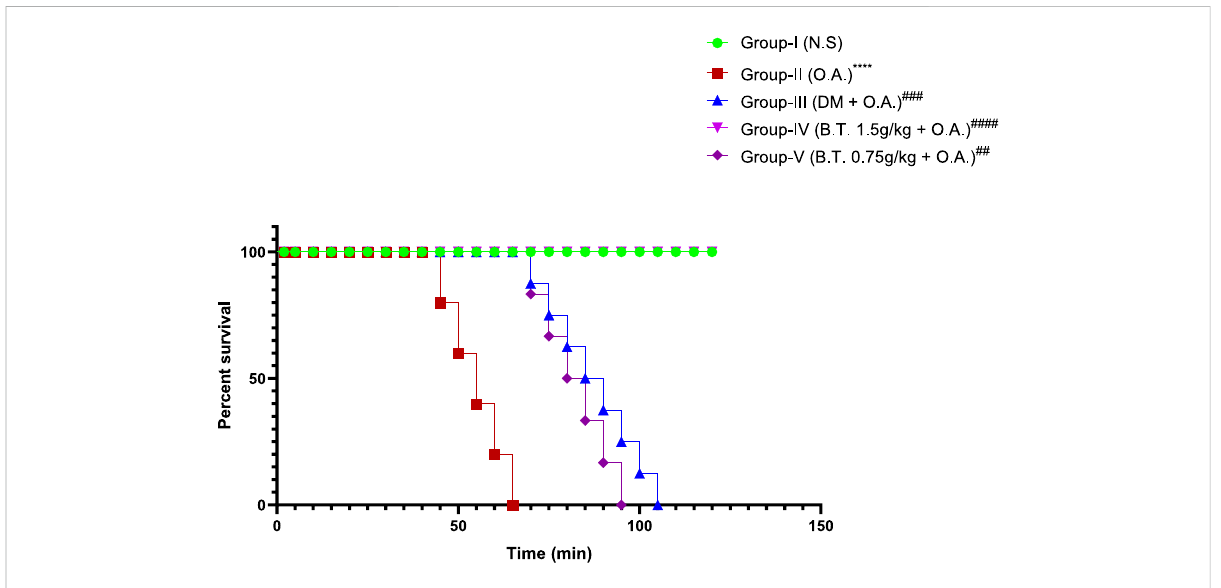
FIGURE 5 Kaplan-Meier survival plot. Kaplan-Meier survival plot. Overall survival in group IV (B.T. 1.5 g/kg b. w.) was similar to group I (normal saline) and signi fi cantlydifferentfromgroupII(oleicacid)asperthelog-rank(Mantel – Haenszel)test. *,p < 0.05,***,p < 0.001,****,p < 0.0001 incomparisonto group I and # ,p < 0.05, ### ,p < 0.001 and #### ,p < 0.0001 in comparison to group